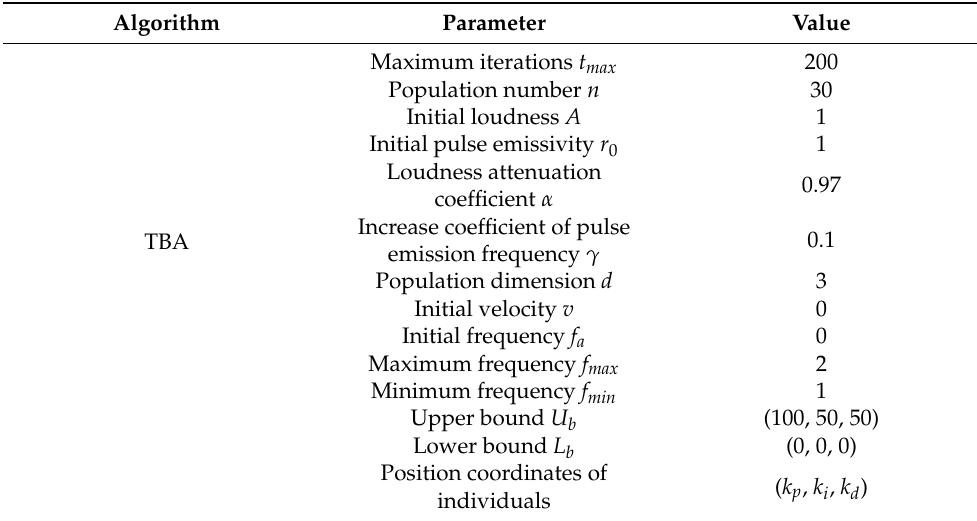
Table 3. Parameter settings of TBA.